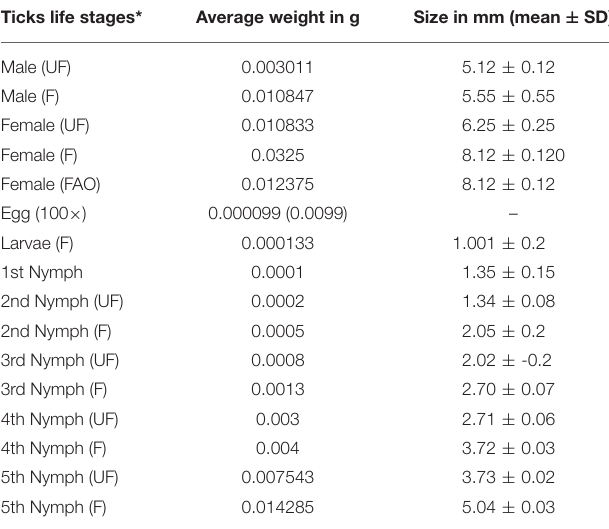
TABLE 4 | Durations of life stages of Argas persicus infesting natural host (domestic fowl).